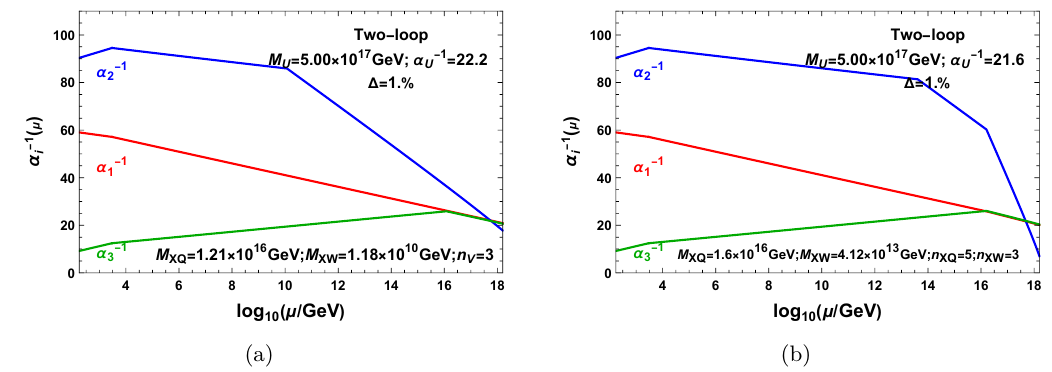
Figure 16 . Two-loop evolution of gauge couplings for the Model 11 without and with vector-like particles. In the model, k achieved by adding 3( XG + XW ) (a) and 5( XQ + XQ ) + 3 XW (b).